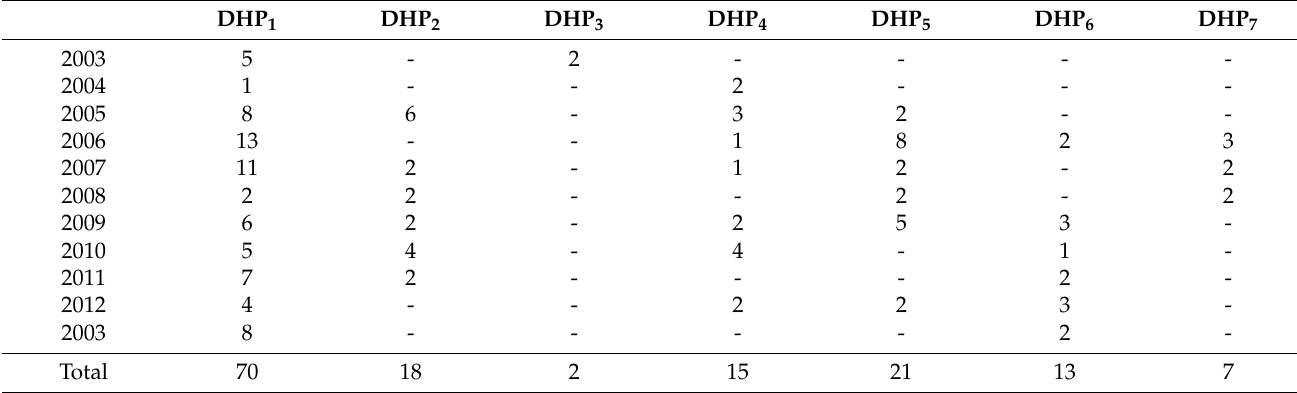
Table 2. Number of complete viral genomes sequenced annually from each duck hunting preserve (DHP). DHP 1 DHP 2 DHP 3 DHP 4 DHP 5 DHP